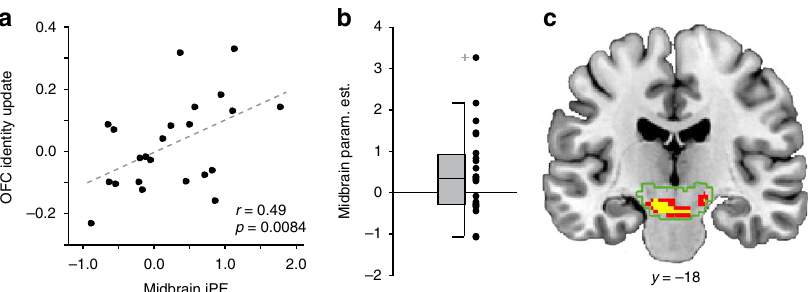
Fig. 6 Relationship between midbrain iPE and changes in OFC identity expectations. a The magnitude of the iPE response in the midbrain ROI is plotted against the change in pattern-based OFC identity expectations from the trial before to after identity reversals. Each dot represents one subject. b Parameter estimates in an anatomical midbrain ROI (green outline in c ) from a trial-by-trial regression of the change in OFC identity expectations on US-evoked activity. The box plot on the left shows the median, quartiles, data extremes, and outliers. Black dots to the right of the box plot represent individual subject data points. c Within the midbrain ROI (green outline) there was a cluster of voxels showing a signi fi cant relationship with the change in pattern-based OFC identity expectations. Red = p < 0.05, uncorrected, and yellow = p <